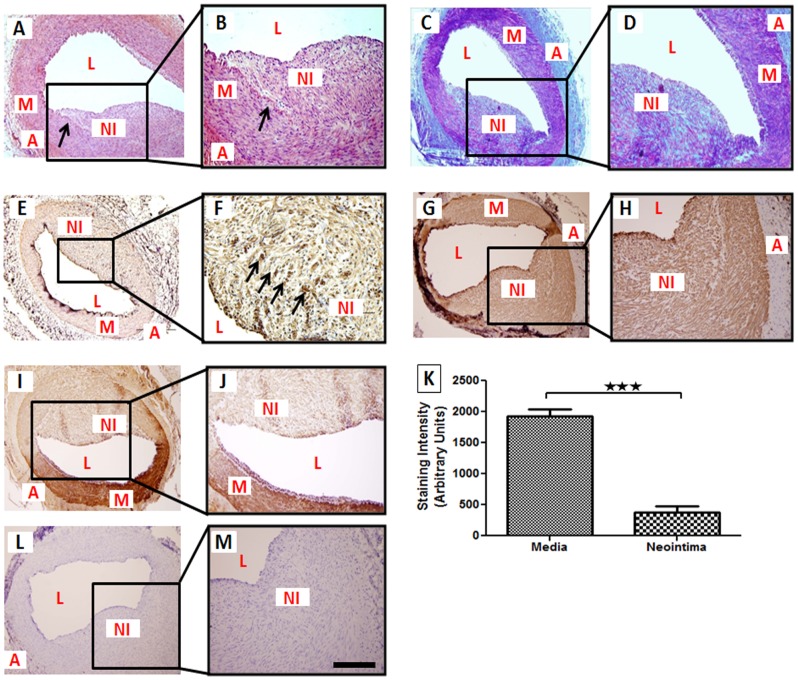
Photomicrographs of post-angioplasty swine coronary artery tissue sections.Paraffin embedded thin sections were cut, deparaffinized and histological analysis was performed using H&E, and Masson's trichrome stains and immunohistochemical analysis was done for TNF-α, VDR, and α-SMA expression. For immunohistochemistry, sections were stained with DAB as chromogen and counterstained using hematoxylin. In the H&E staining, the fracture (arrows) in the internal elastic lamina (IEL) and neointimal thickening were observed (A–B). In the Masson's trichrome staining of the tissue sections, collagen deposition in the neointimal area was prominently present(C–D). TNF-α-positive cells in post-angioplasty coronary artery are shown by arrows (E–F). The α-SMA was thoroughly expressed both in neointima and medial layer (G–H). Expression of VDR was decreased in neointima compared to media (I–J). Quantification of VDR staining in neointima and media of post-angioplasty coronary arteries was done by NIH image J (K). Two-tailed unpaired student t tests were performed to determine statistical relevance. Data are shown as mean ± SEM. ***P<0.001. Negative control is shown (L–M). (N = 6) scale bar 100 µm, magnification (100×–400×); A: adventitia L: lumen, M: medial layer, NI:neointima.